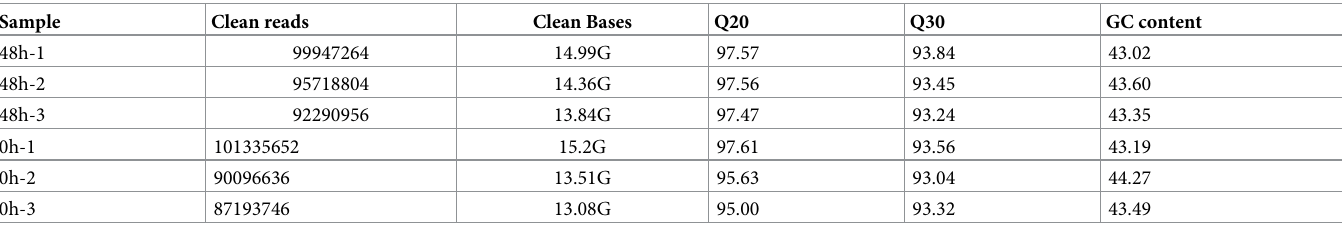
Table 1. Sequencing data for six libraries obtained by RNA-seq.